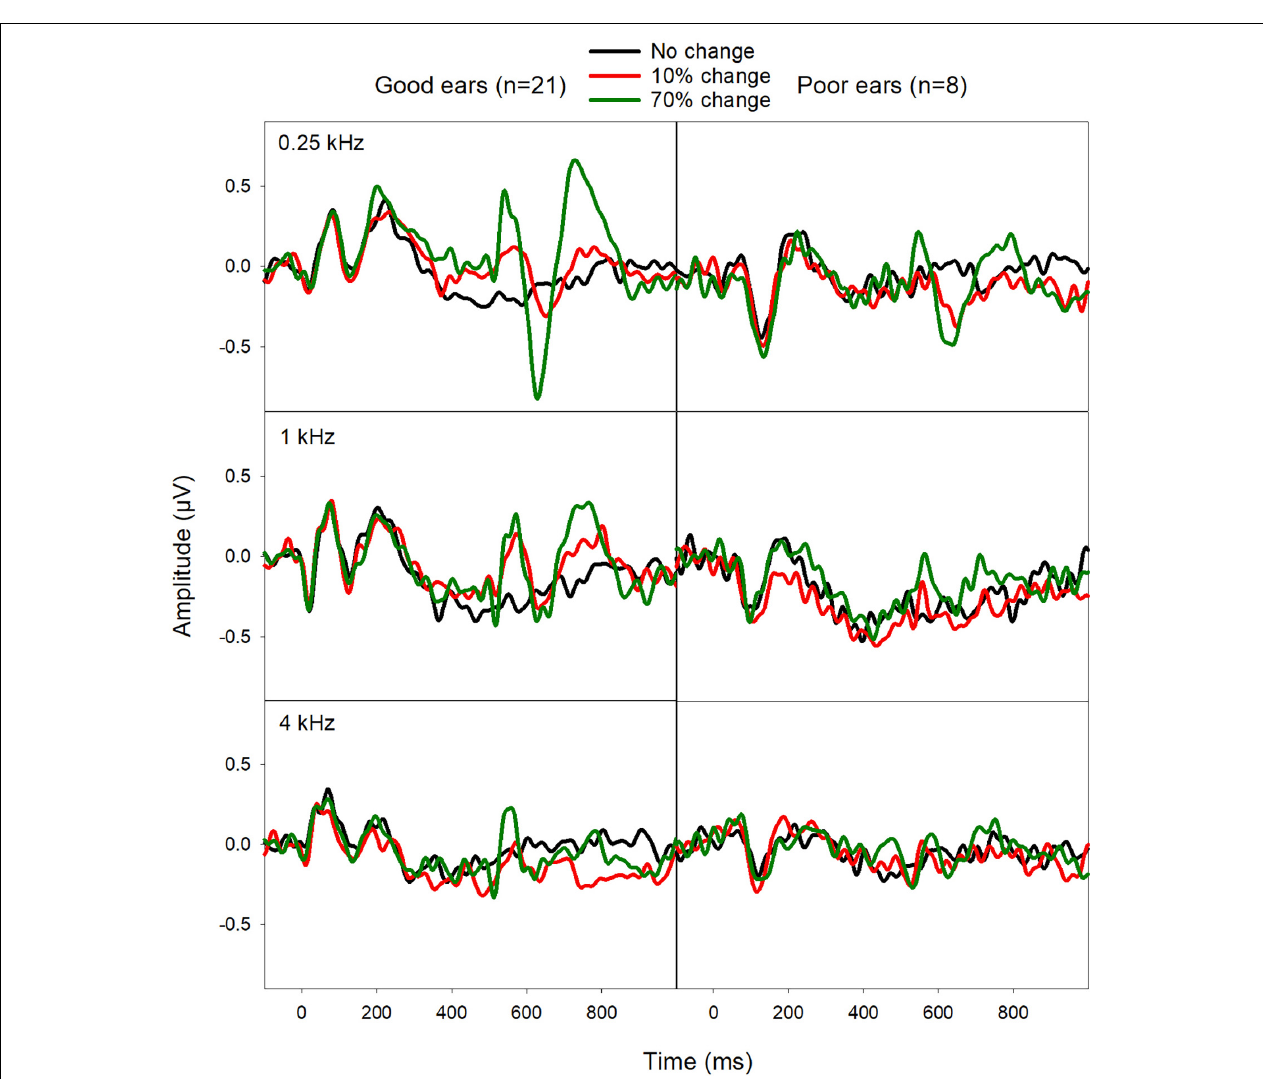
FIGURE 3 | Mean ERPs from good CI ears (mean FCDT < 10%, n = 21) and poor CI ears (mean FCDT ≥ 10%, n = 8). The ACCs were more prominent for the f base at 0.25 kHz than for 1 and 4 kHz. The ACCs were worse in the poor CI ears compared to the good CI ears.